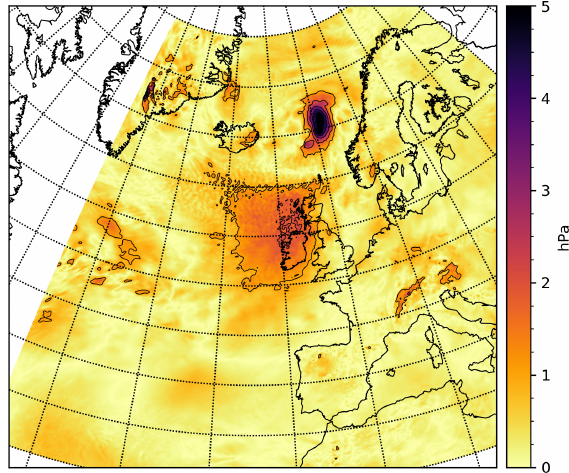
Figure 9. ECMWF-IFS absolute pressure jump at 24 De- cember 2016 00:00, i.e. absolute pressure difference between 2016122400 + 0h (analysis step) and 2016122318 + 6h. The spa- tial average over the neatl area (Fig. 5) is 0.81hPa. Note the changed colour scale: the maximum pressure difference is 5.7hPa, occurring at point 64.793, 0.773 (lat.,